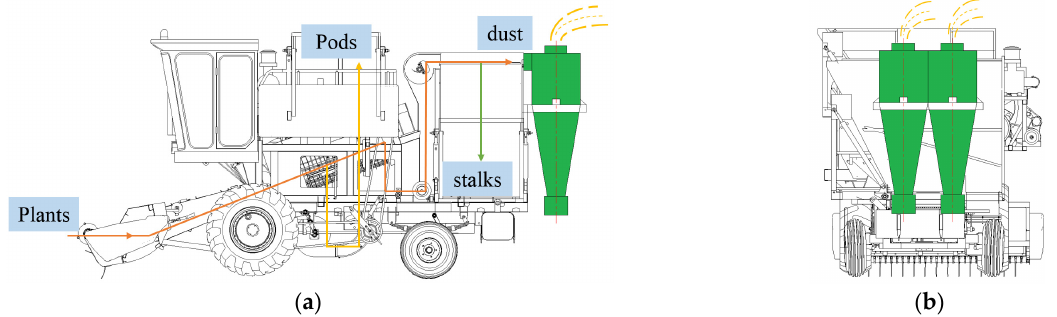
Figure 1. Diagrams of peanut whole-feed combine with a dust suppression device: ( a ) side view; ( b ) rear view.